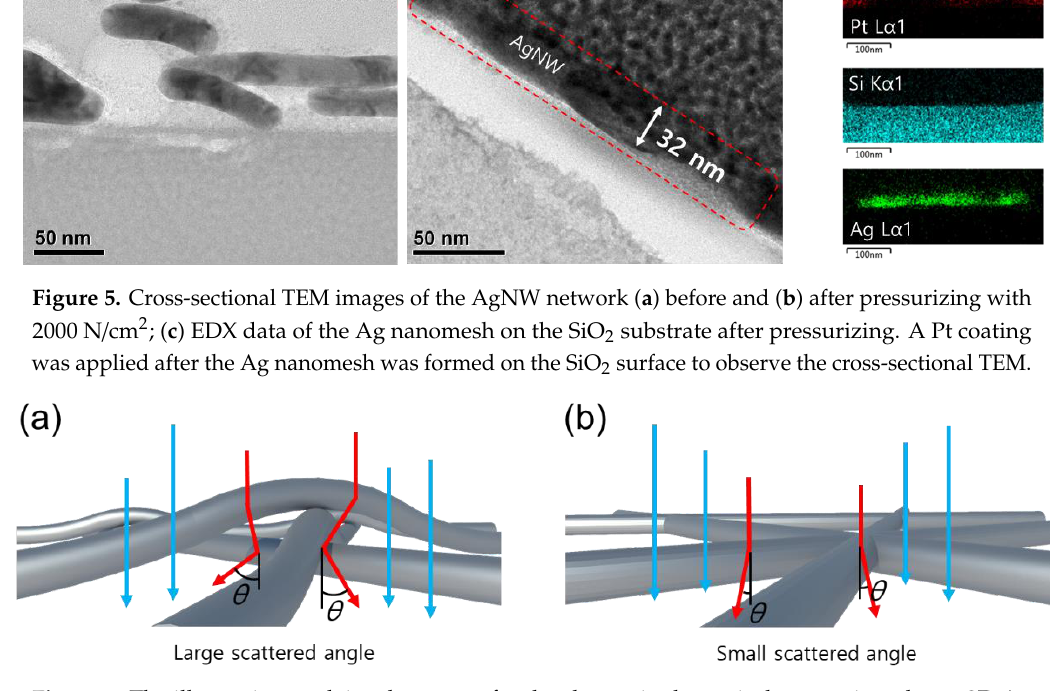
Figure 7. ( a ) The thickness of the AgNW-embedded polydimethylsiloxane (PDMS) film using various weight ratios (from 1:0 to 1:30) of PDMS:Butanol as a function of the spin speed. SEM images of AgNWs exposed to the outside of PDMS for ( b ) the 3D AgNW network and ( c ) the 2D Ag nanomesh (pressurized at 2000 N/cm 2 ). Figure 7b,c show the SEM images of the AgNWs on the PDMS surface for the 3D AgNW network and the 2D Ag nanomesh, respectively. Inset figures are the images of the Ag area on the PDMS surface for calculating the total Ag area ratio using a surface area measurement software (Image J; NIH). The 2D Ag nanomesh-embedded PDMS showed a larger Ag electrode area on the PDMS surface, as shown in the SEM images. The calculation also showed that the ratio of the AgNW electrode to the PDMS area was 24.5%, compared to 12.8% for the 3D AgNW network-embedded PDMS, showing that more current flows for the 2D Ag nanomesh-embedded PDMS. The effect of the flexible/stretch stability of the AgNW-embedded PDMS electrodes on the change in resistance was investigated, and the results are shown in Figure 8. For the AgNW network and the Ag nanomesh, electrodes (7 cm × 5 cm × 140 nm) were fabricated and, after attaching to a PDMS support, the bending/stretching stability was investigated. After forming Ag paste stripes (Figure S2a, Supporting Information), the change in resistance as a function of the mechanical stability was measured using a four-point probe method and a lab-made bending/stretching test machine. Figure 8a shows the change in sheet resistance of the AgNW-embedded PDMS electrodes, measured as a function of the bending cycle. The mechanical integrity of the electrodes was measured using a lab-made bending test system bended to a 3 mm radius of curvature. In the case of a 3D AgNW network-embedded PDMS electrode, a